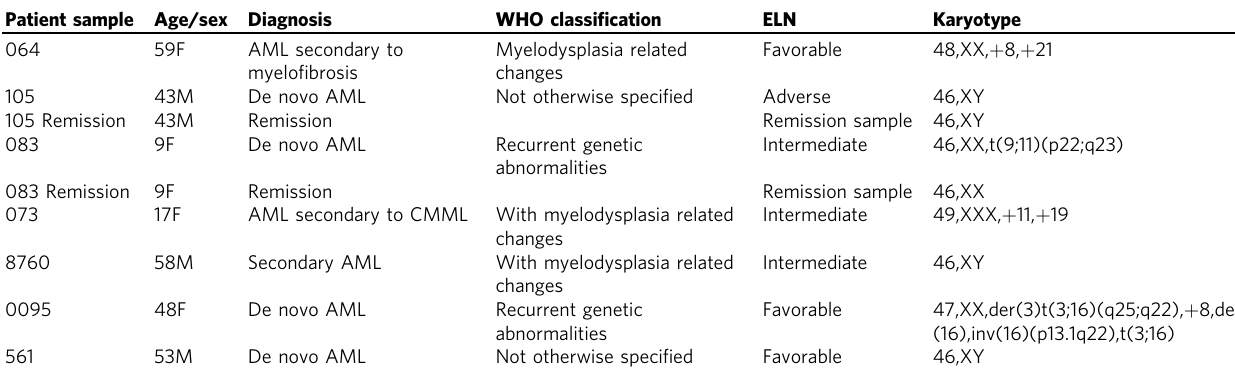
Table 2 Clinical features of AML patients harboring a histone mutation Patient sample Age/sex